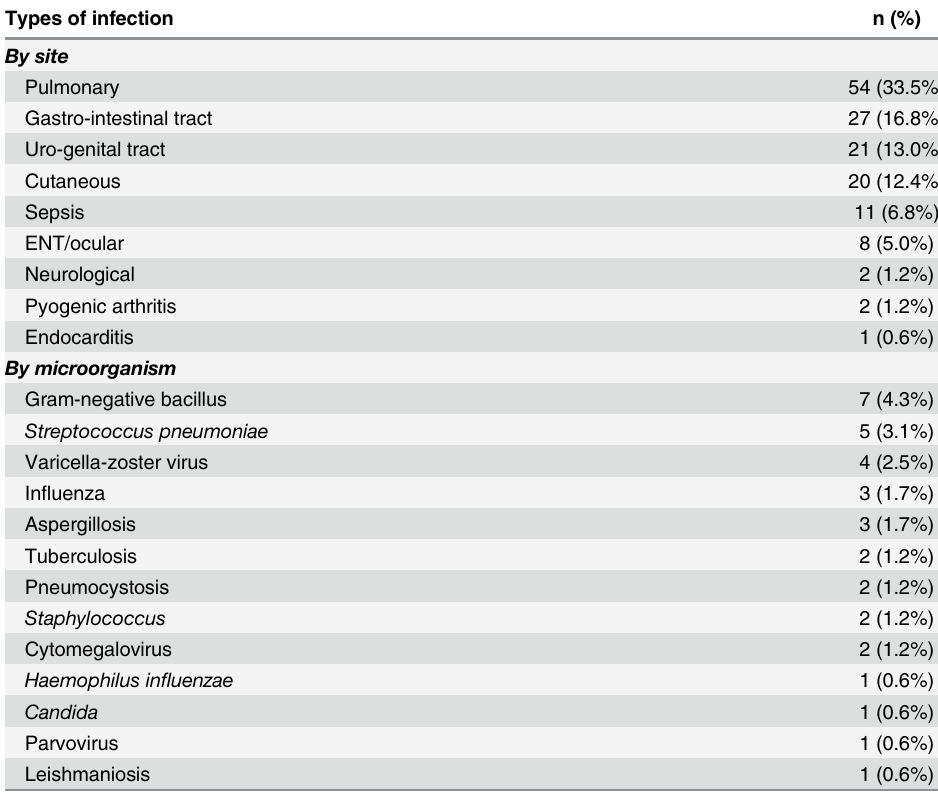
Table 2. Description of severe infections that occurred during the follow-up of the 1805 incident pri- mary ITP adults persistently treated who entered the FAITH cohort between the 1 st of July 2009 and the 30 th of June